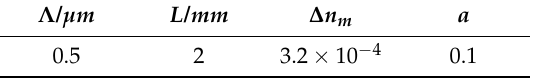
Table 2. Parameters of the FBG.